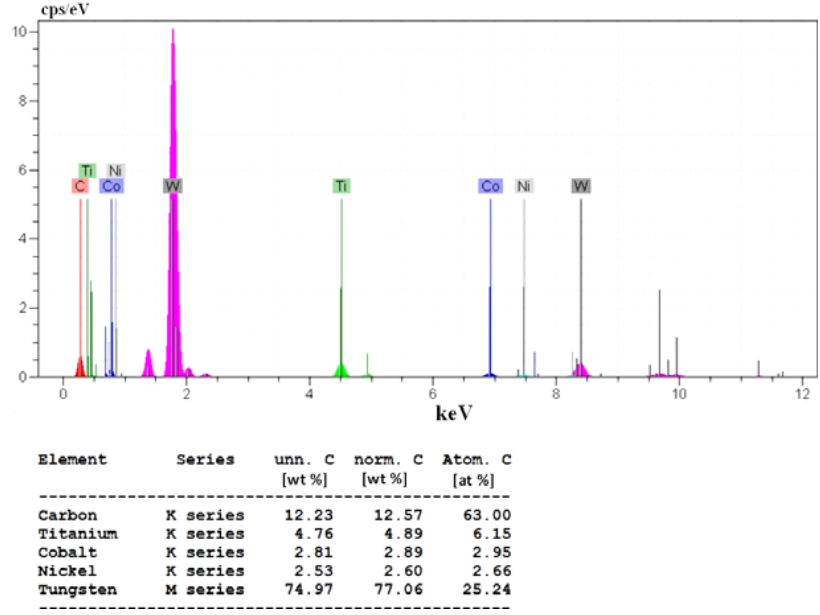
Figure 2. Energy Dispersive X ‐ ray Spectroscopy (EDS) analysis for reference electrode (SCE). Table 2. Condition of specimens and their code.